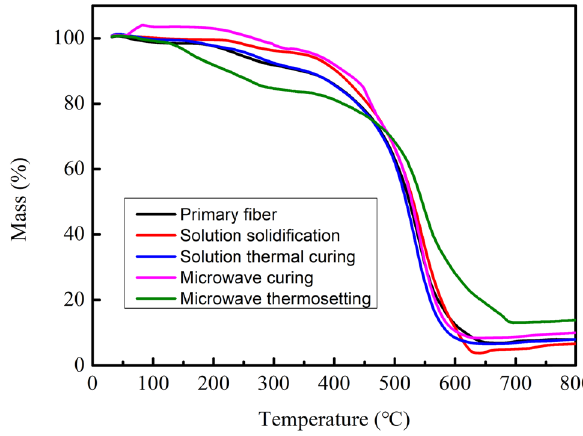
Figure 7: TGA diagram of di ff erent fi bers in air atmosphere.